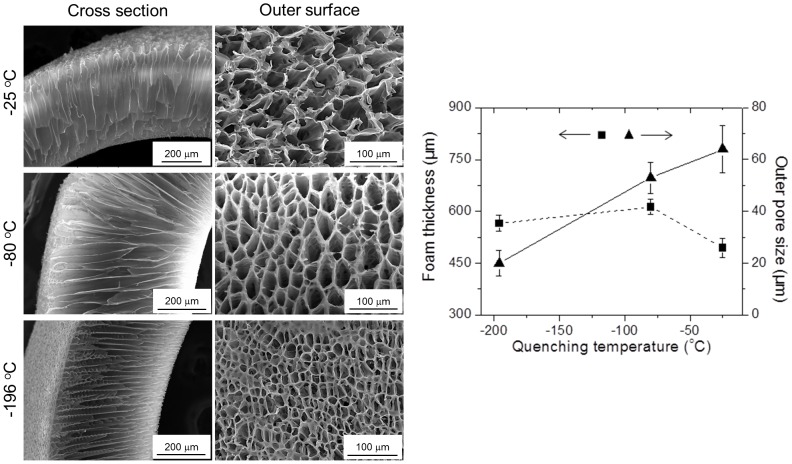
Influence of the quenching temperature.SEM images of the cross section and the outer surface of PLCL300 foams (5% w/v) prepared at various quenching temperatures (−25, −80 and −196°C) for 30 s revealed that the increase in the quenching depth promoted the organization of pores with a significant decrease in the average pore size, but with a slight alteration in the overall foam thickness. Measurements were done by Image J (n = 25). The differences in the foam thickness or the pore size between any two groups were found to be statistically significant. The correlation coefficients between the quenching temperature and the outer pore size and the foam thickness were calculated to be −0.99 and +0.42, respectively.